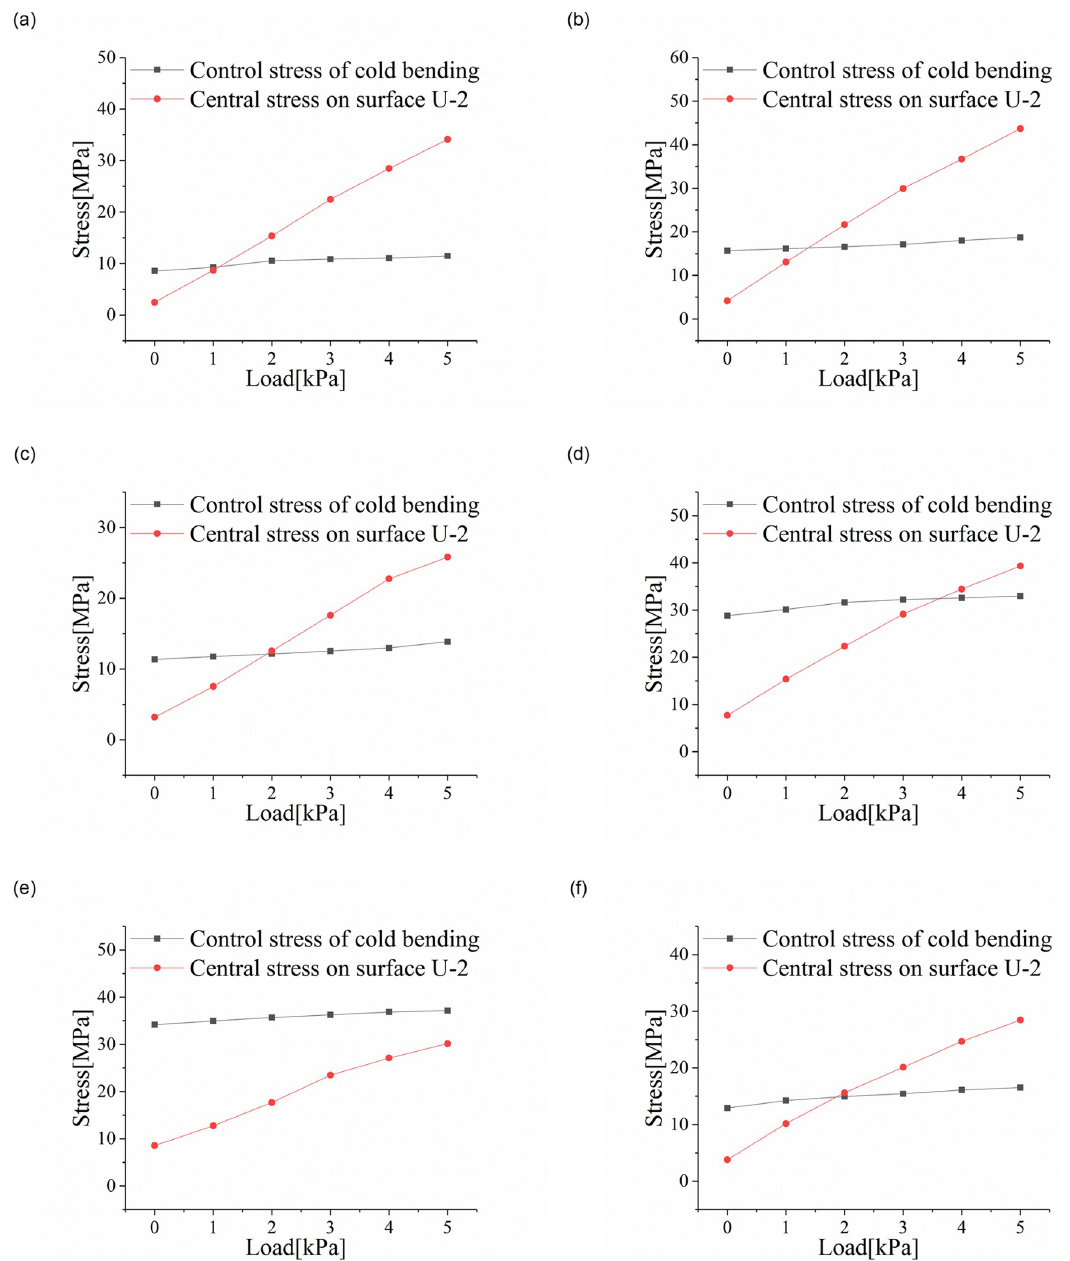
Fig 8. Stress on the Sub-diagonal of load test. (a) SJ2; (b) SJ3; (c) SJ4; (d) SJ5; (e) SJ7; (f) SJ9. The range R in the orthogonal experiment analysis is the difference between the maximum j and minimum values of the average value of each level under factor j , which can show the influence of factor j . In this test, the range of cold bending distortion rate, glass thickness and cavity thickness are R , R and R , respectively. As we can see from the figures, cold-bent tor- β t tc sion rate could cause the greatest influence on the stress of the plate center with a stress range ( R ) of 10.14, the largest among all curves. Besides, it can be seen from Fig 10(a) that as the β cold-bent torsion rate rose, the maximum stress at the center of U-2 grew faster and faster.